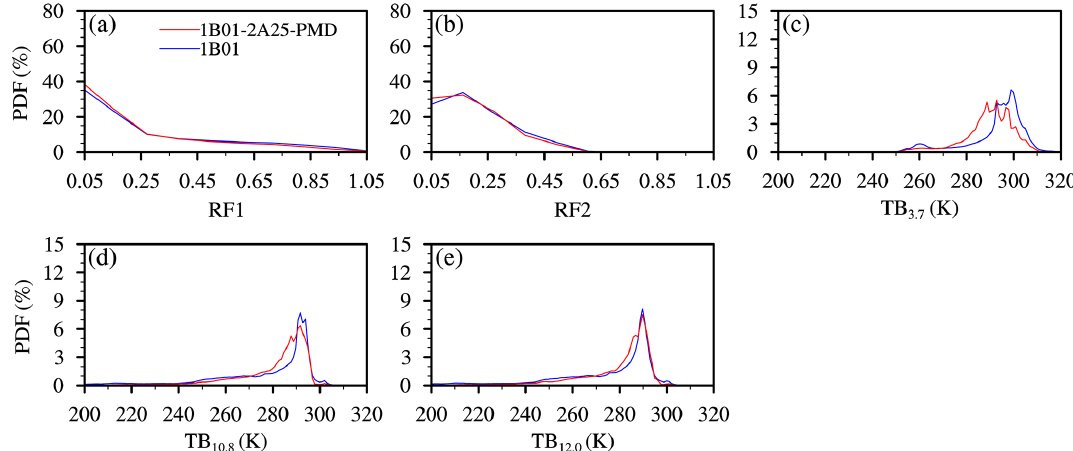
Figure 1. PDFs of (a) RF1, (b) RF2, (c) TB 3 . 7 , (d) TB 10 . 8 and (e) TB 12 . 0 in 1B01 (blue line) and 1B01-2A25-PMD (red line) for orbit number 37362 on 5 June